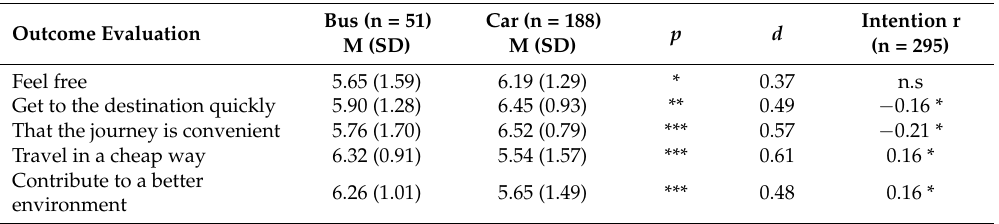
Table 6. Outcome evaluation for a journey in general. Mean, SDs, Cohen’s d for either bus users or car drivers and Pearson’s correlation with intention to use the